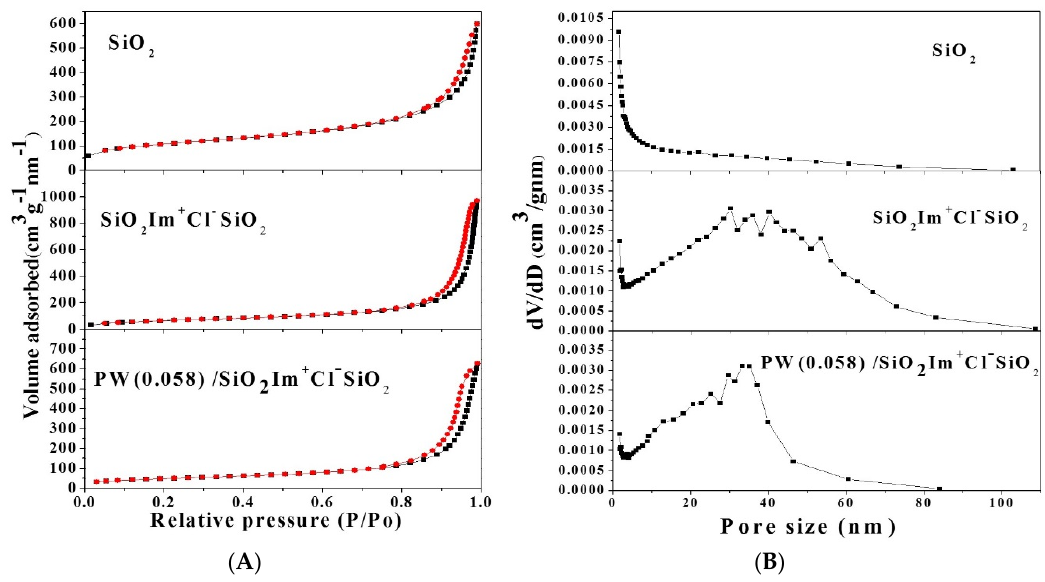
Figure 5. Nitrogen adsorption-desorption isotherms ( A ) and pore size distribution ( B ) of the samples